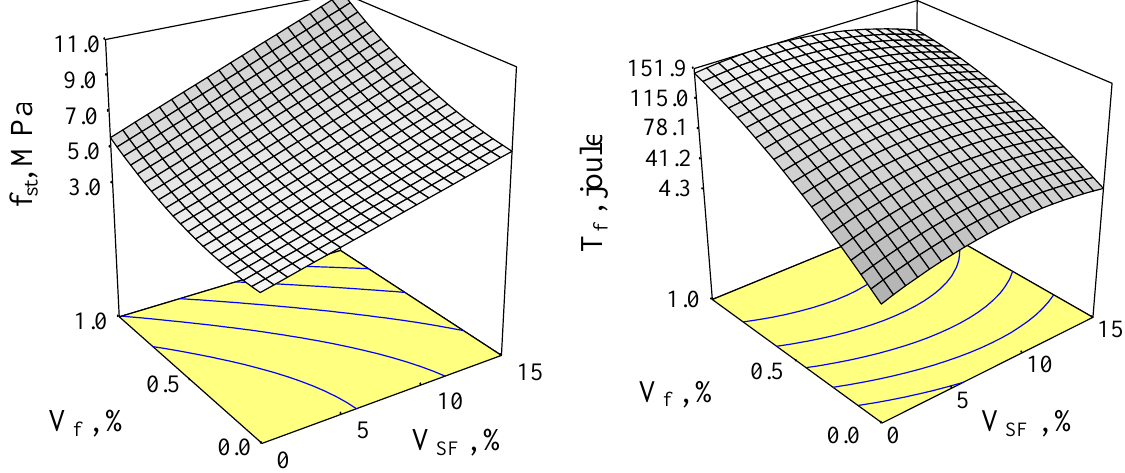
Figure 2. Response surfaces of f st and T for the fiber aspect ratio of 65.